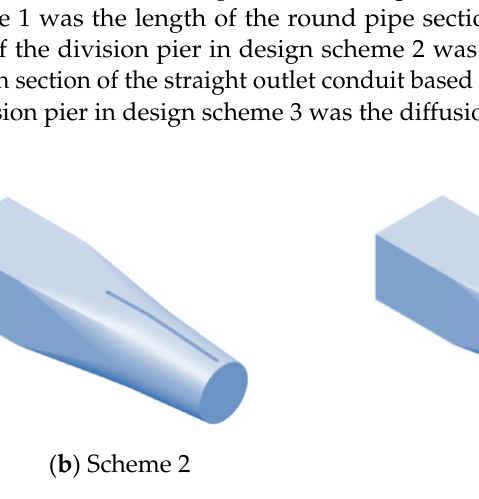
Figure 11. Design scheme of straight outlet conduit.